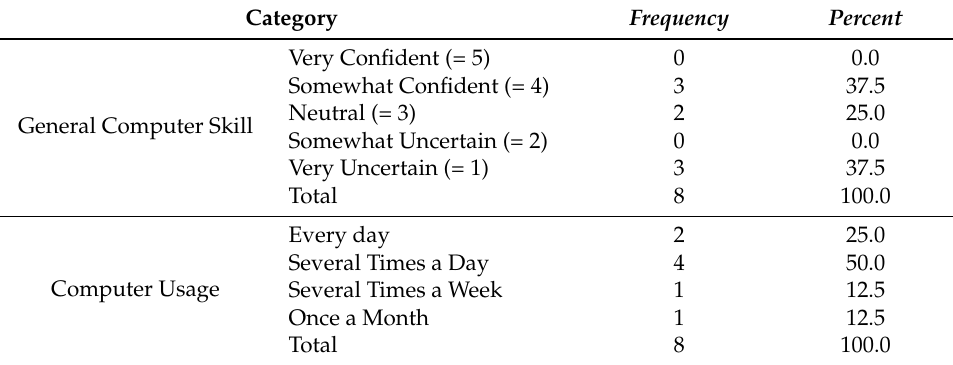
Table 4. Baseline computer